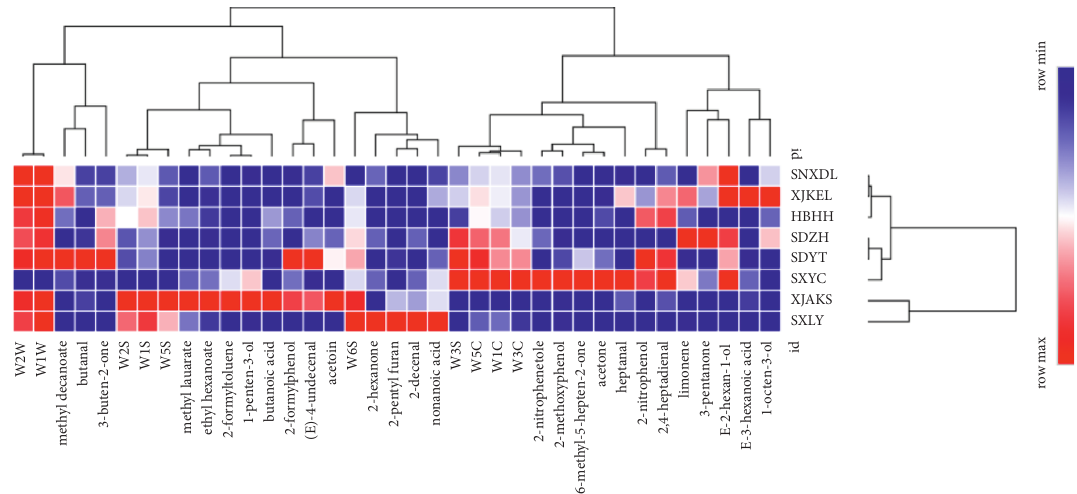
Figure 7: Correlation analysis between different components and sensors by